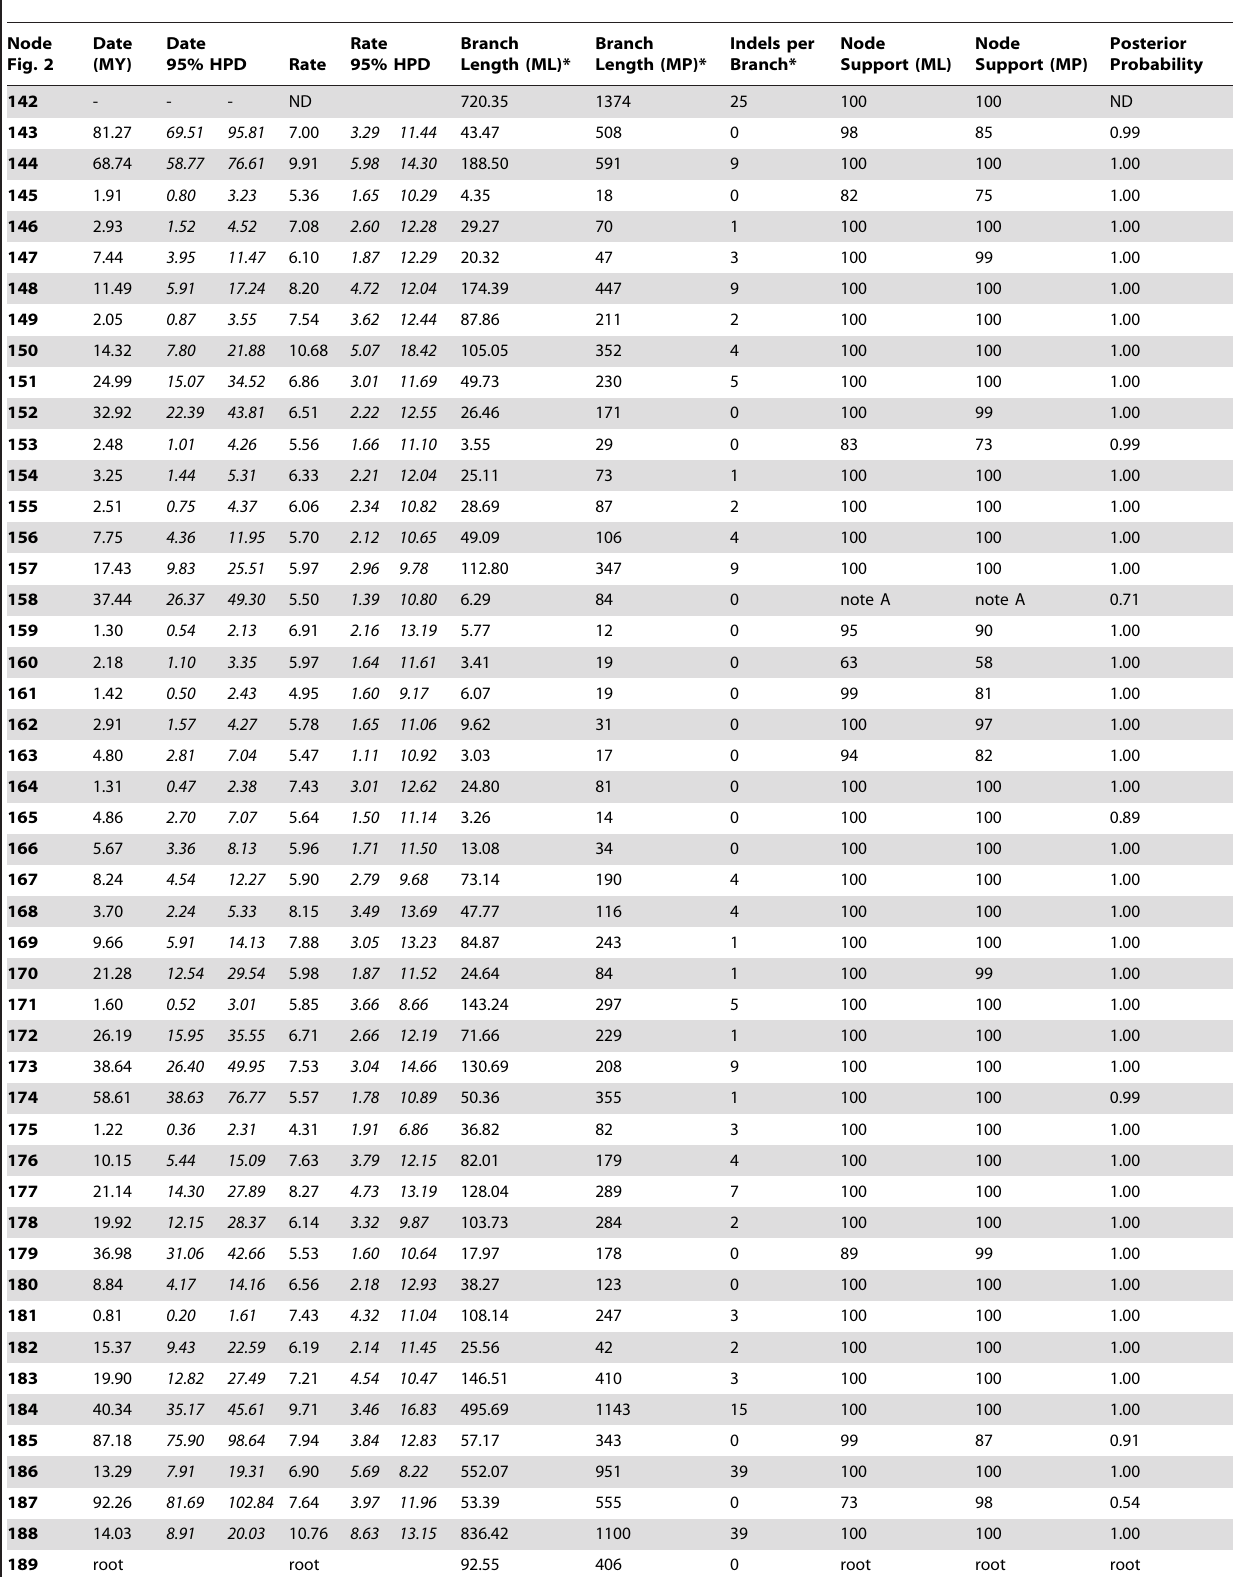
Table 1. Node Support, Branch Lengths, Divergence Times, and Nucleotide Substitution Rates for Strepsirrhini, Tarsiiformes, and Outgroups in Figure 2.